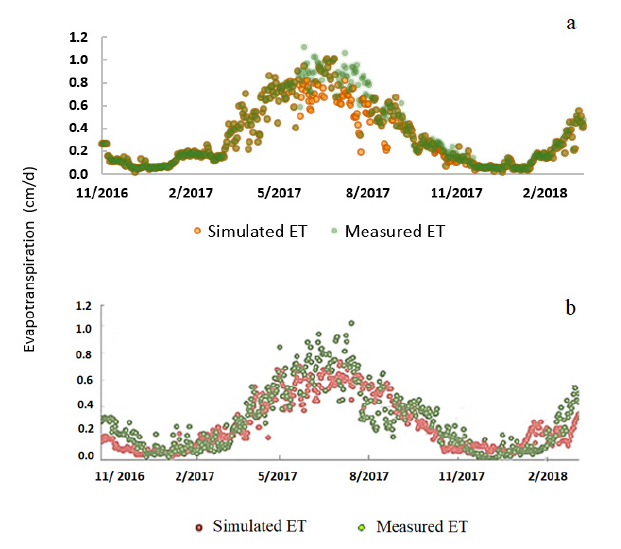
Figure 11. Simulated and measured actual evapotranspiration at ( a ) the ASL site and ( b ) the ASH site.